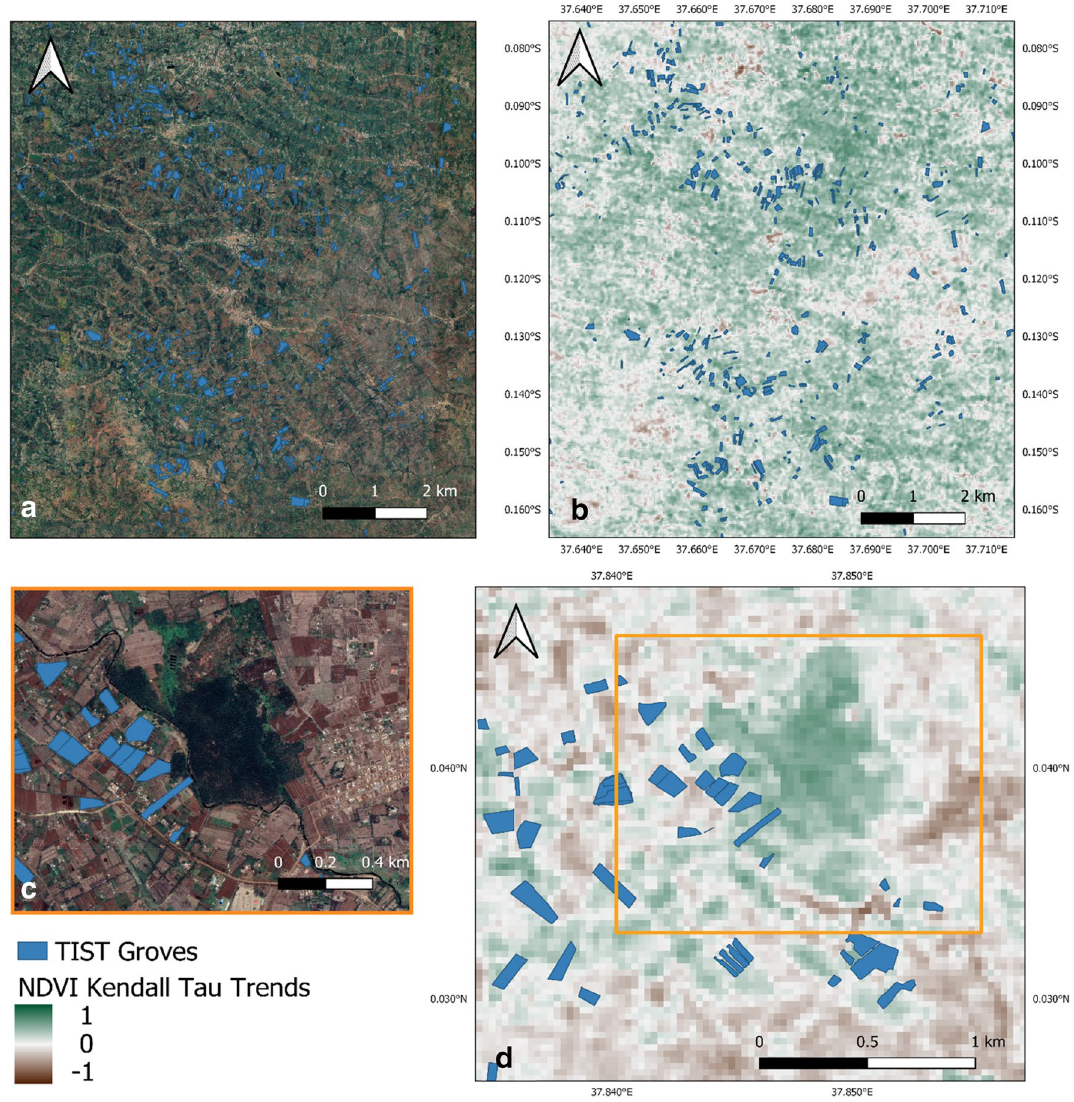
Figure 3. Examples of greening in the vicinity of TIST groves: (a,b) Example of a group of TIST sites within a greening agricultural landscape. (a) TIST sites within a heterogenous landscape. (b) NDVI Kendall Tau greening trends for this area. (c,d) TIST sites in Meru County bordering a small woodland. (c) Extent of this small woodland area neighbouring TIST groves. (d) Greening of the woodland. This greening effect is likely to be caused by a reduction in the extraction of firewood and forage from these woodlands and represents a very specific form of natural vegetation improvement. (a,c) Map data: ©2020 Google, CNES/Airbus, Maxar Technologies. Figure created with